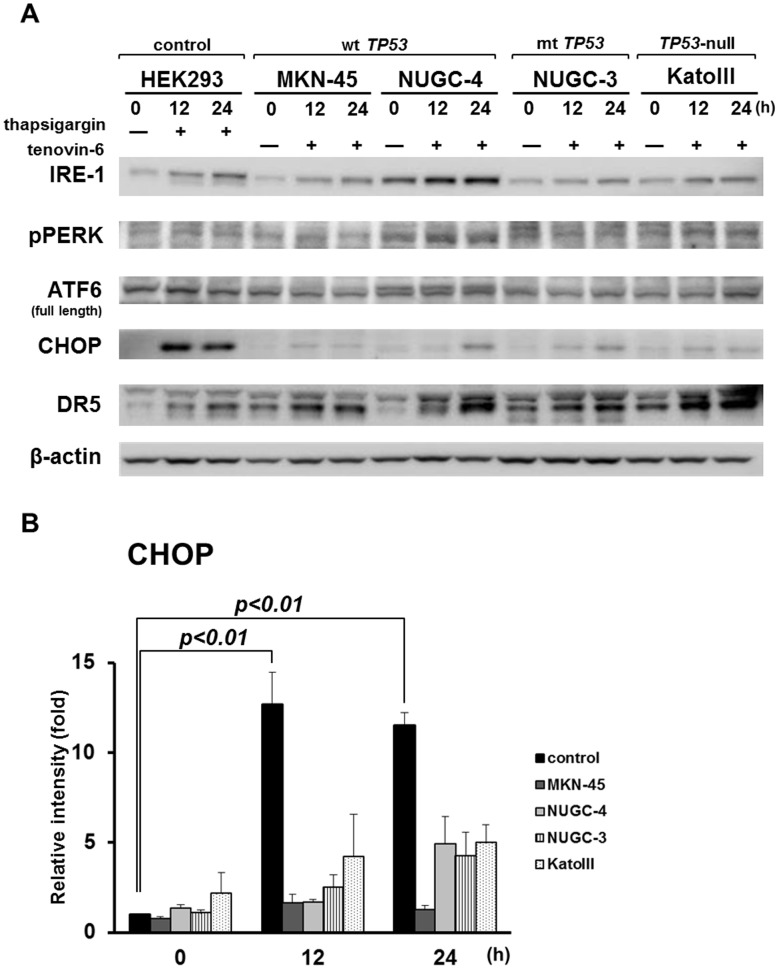
Expression of proteins associated with ER stress in gastric cancer cell lines treated with tenovin-6.A: Expression of proteins associated with ER stress in gastric cancer cell lines before and after treatment with 10 µM tenovin-6. Thapsigargin at 3 µM was administered to HEK293 cells as a control. A doublet of DR5 shows its precursor and mature isoforms. B: Relative intensity of expression of CHOP in cell lines tested is shown. The statistical significance of differences between groups was evaluated using Dunnett's test.